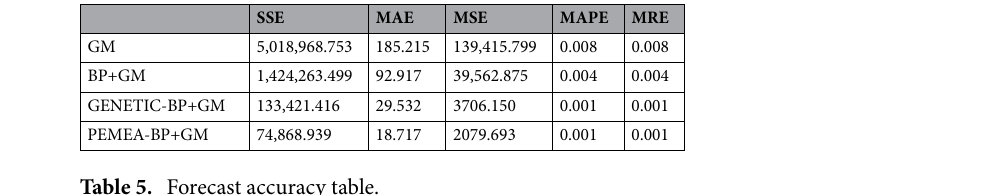
Table 5. Forecast accuracy table.